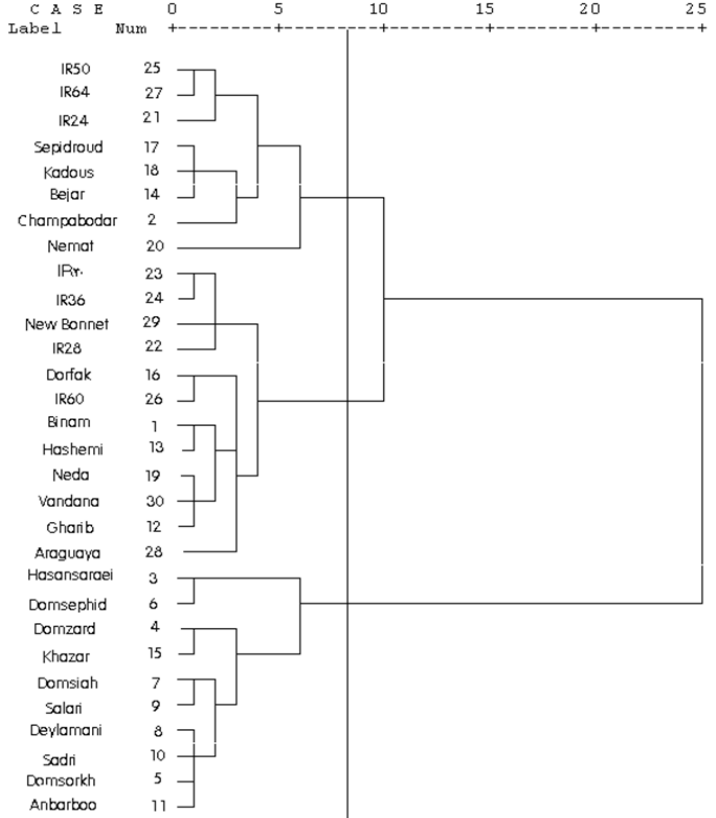
Fig. 1. Cluster analysis dendrogram of 30 studied rice cultivars according to all measured traits in drought stress